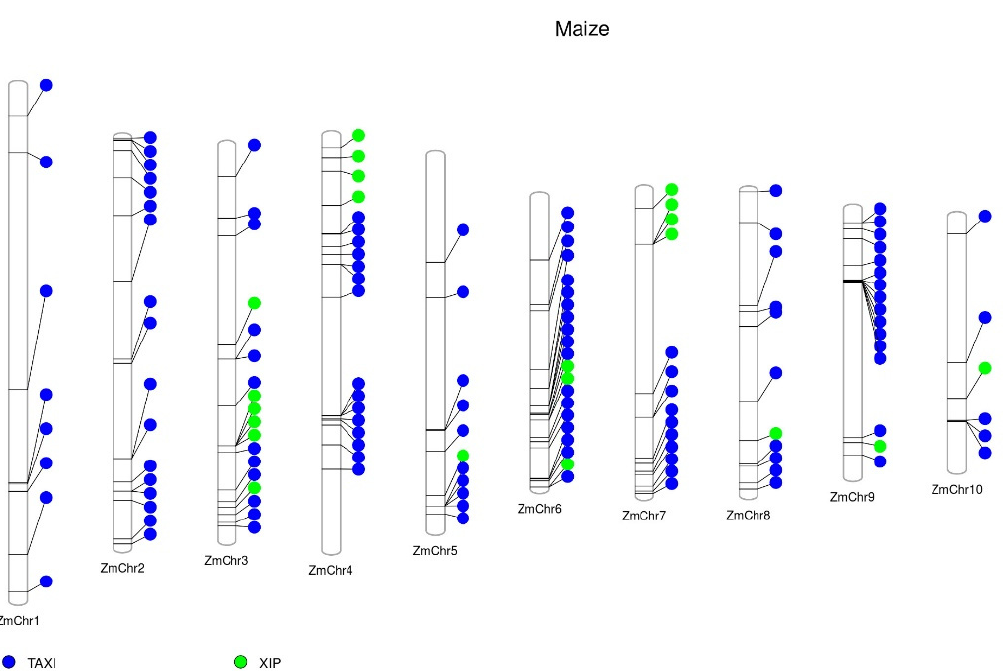
Figure 2. Distribution of xylanase inhibitors (XIs) in maize ( Zea mays ) chromosomes. The publicly available protein sequences of maize were downloaded from the Phytozome database (https://phytozome-next.jgi.doe.gov/, accessed on 1 September 2022). The conserved protein domains of the XIs were predicted in protein sequences by HMMER software (http://hmmer.org/) using a protein family hidden Markov model (HMM) profile (Pfam) database [38]. ZmChr, chromosome. Web-based interface PhenoGram was used to annotate the genes’ location on the chromosome [40].